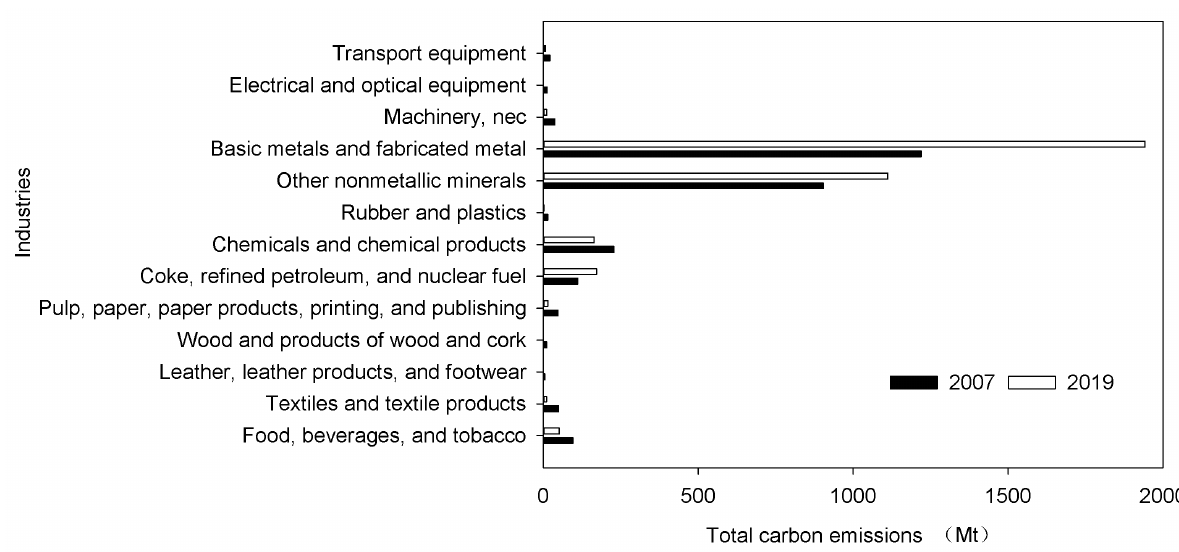
Figure 2. The proportion of electricity consumption in China’s 13 manufacturing industries in 2007 and 2019.